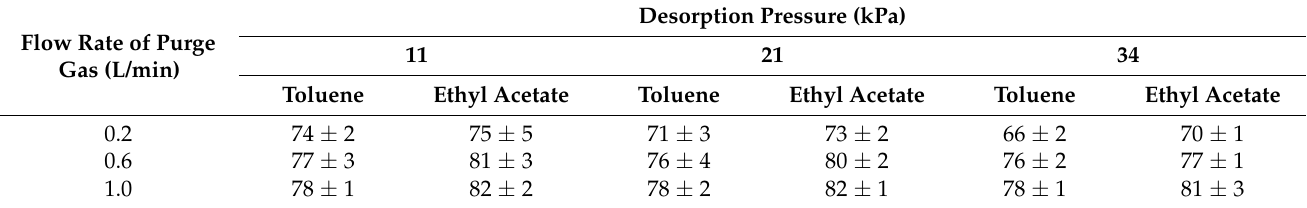
Table 4. Desorption ratio (%) of toluene and ethyl acetate at different flow rates of purge gas and desorption. Flow Rate of Purge Gas